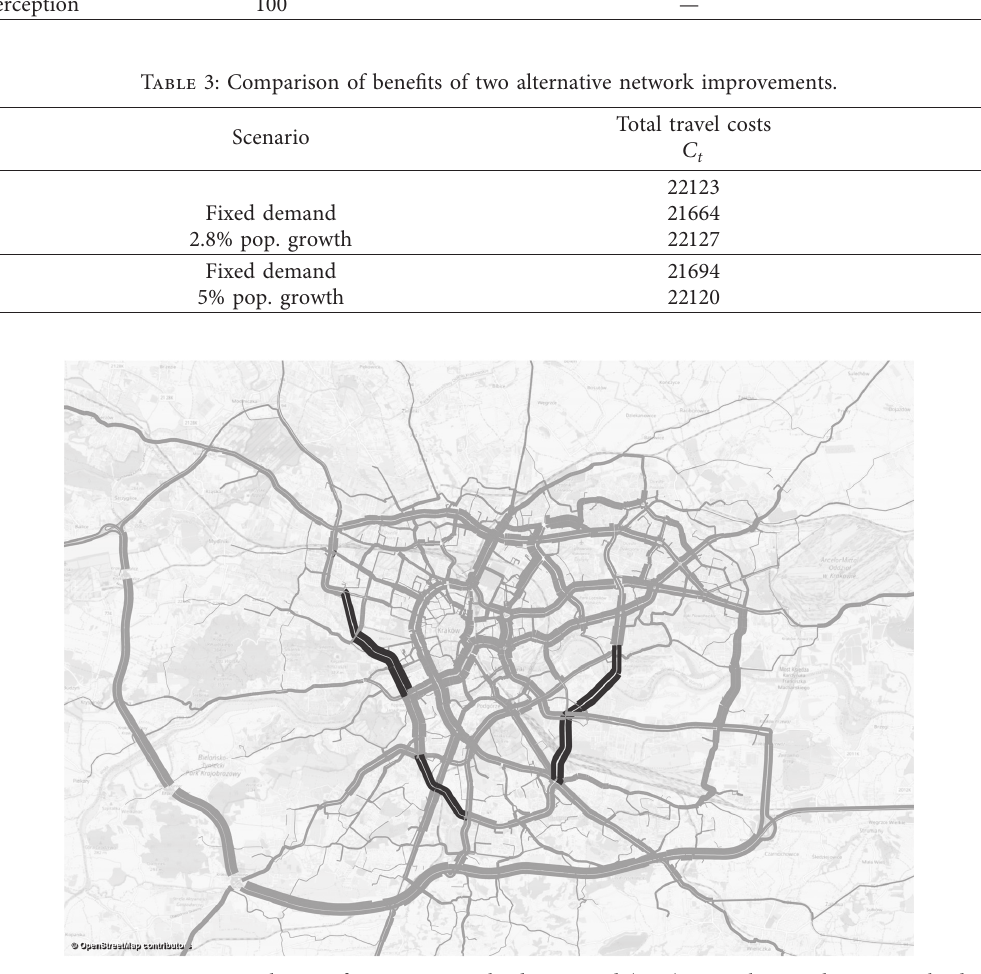
Figure 13: Alternative improvement, completion of an inner-city third ring road (RR3) in Krakow with two new bridges crossing the Vistula river (new arcs marked with solid black; bars denote morning peak